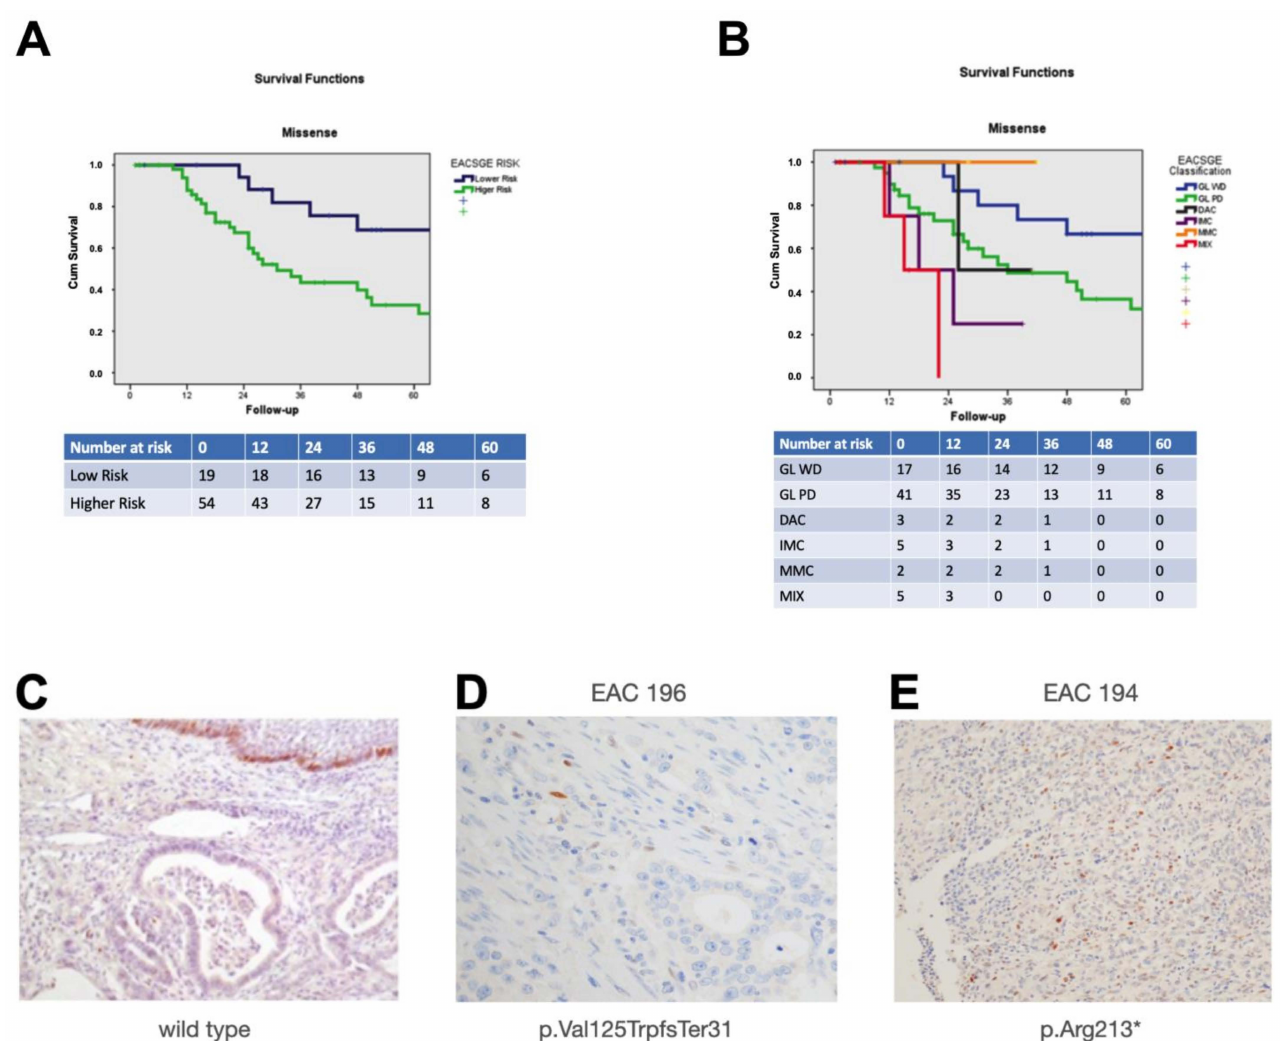
Figure 2. Cancer-specific survival of EAC cases with TP53 missense variants and p53 expression profiles. ( A ) Data are shown according to the higher and lower risk groups. ( B ) Data are shown for the EACSGE morphological subgroups. ( C – E ) Immunohistochemical patterns for p53 immunostaining in the EAC cases with different types of variants of TP53 : ( C ) control case with no variant in TP53 vs. loss of function (LOF) ( D , E ). Scale bar 100 µ